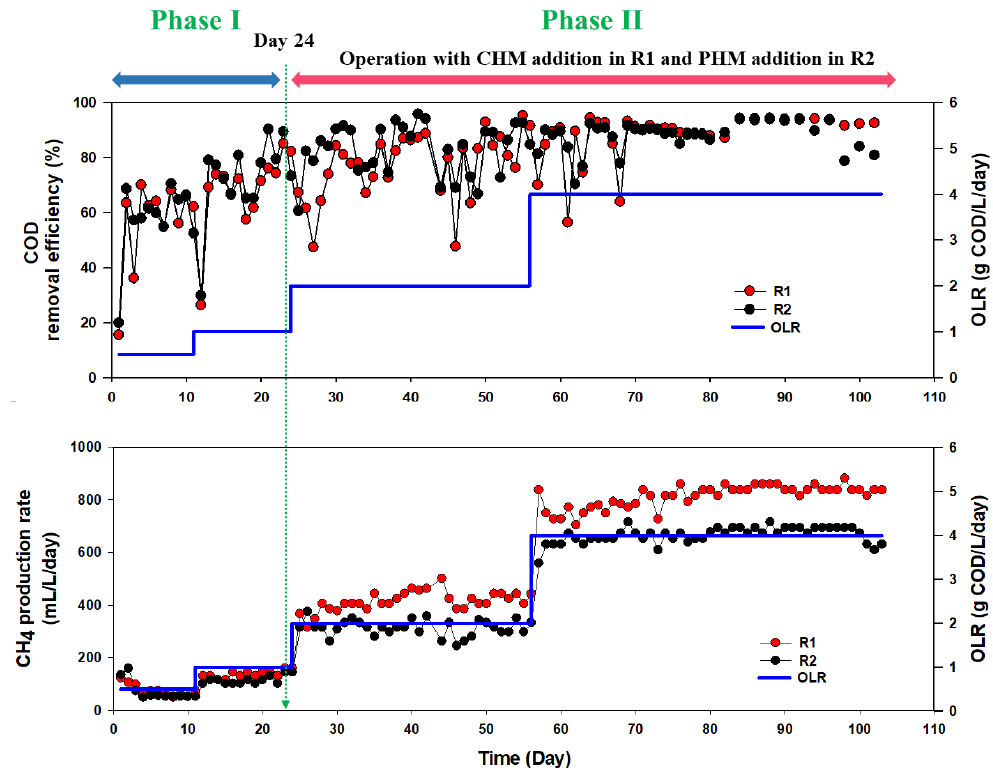
Figure 1. Daily variation of chemical oxygen demand (COD) removal efficiency and CH 4 production rate in R1 and R2 at various organic loading rates.